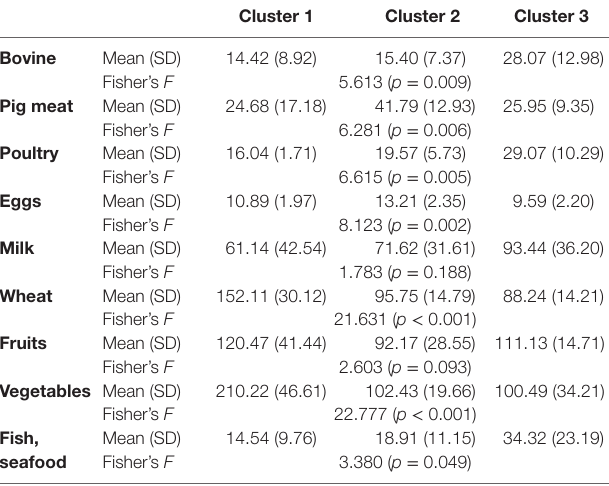
tabLe 1 | Food supply (kilograms per capita per year) in each